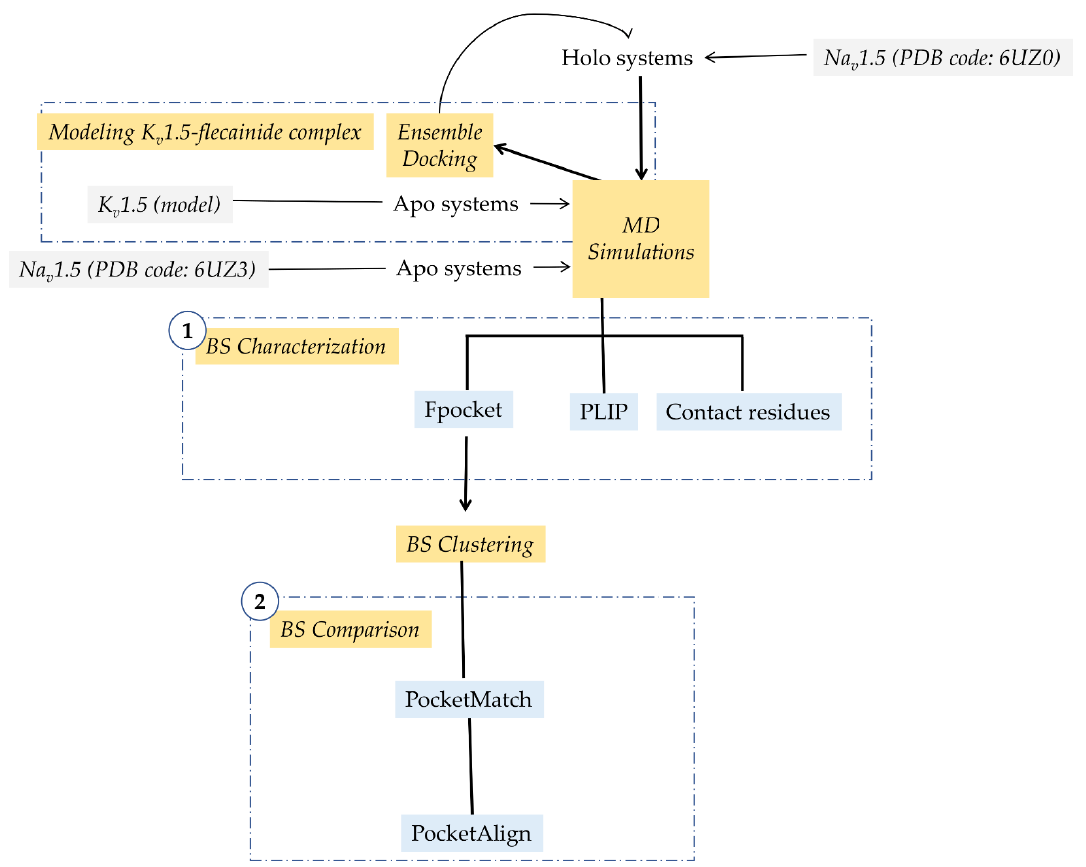
Scheme 1. General workflow describing steps in methodology . In color blue, software are displayed. The processes are indicated in yellow. PDB: Protein Data Bank, BS: binding The processes are indicated in yellow. PDB: Protein Data Bank, BS: binding site, MD: molecular dynamics site, MD: molecular dynamics.